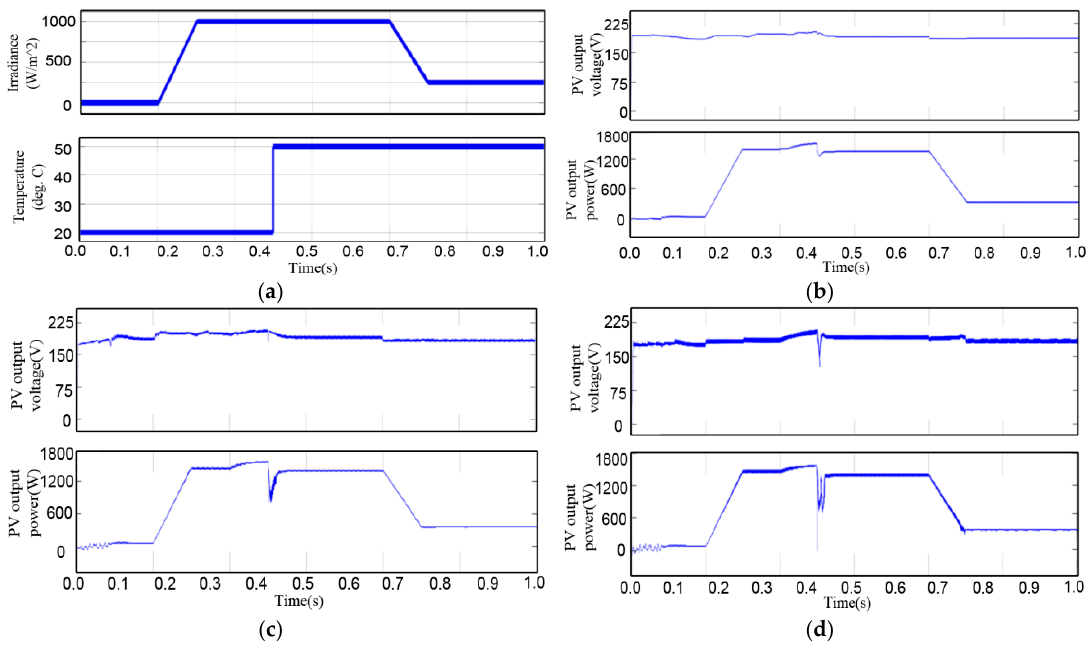
Figure 12. MPPT tracking simulation results of different control methods in variable radiation and step temperature: ( a ) Changing solar radiation and step temperature simultaneously; ( b ) VUFLC; ( c ) FLC; ( d ) INC.